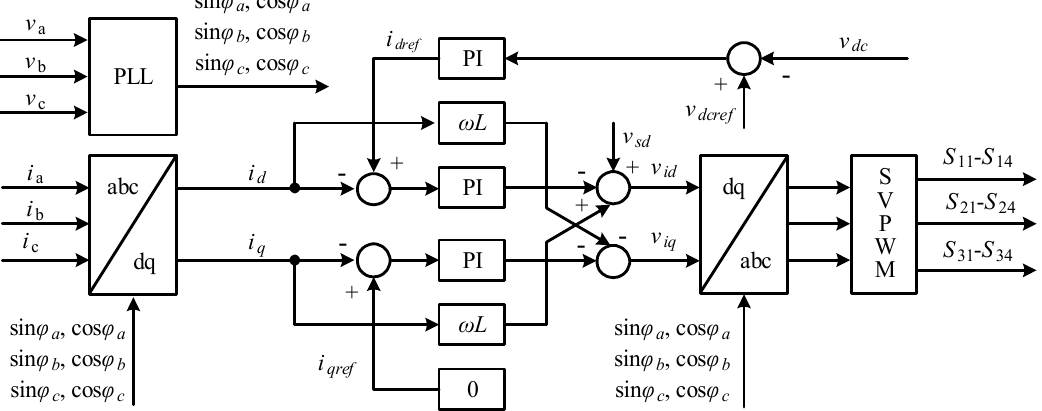
Figure 3. The control strategy and modulation strategy of the three-phase three-level neutral point clamped (3L-NPC) rectifier.